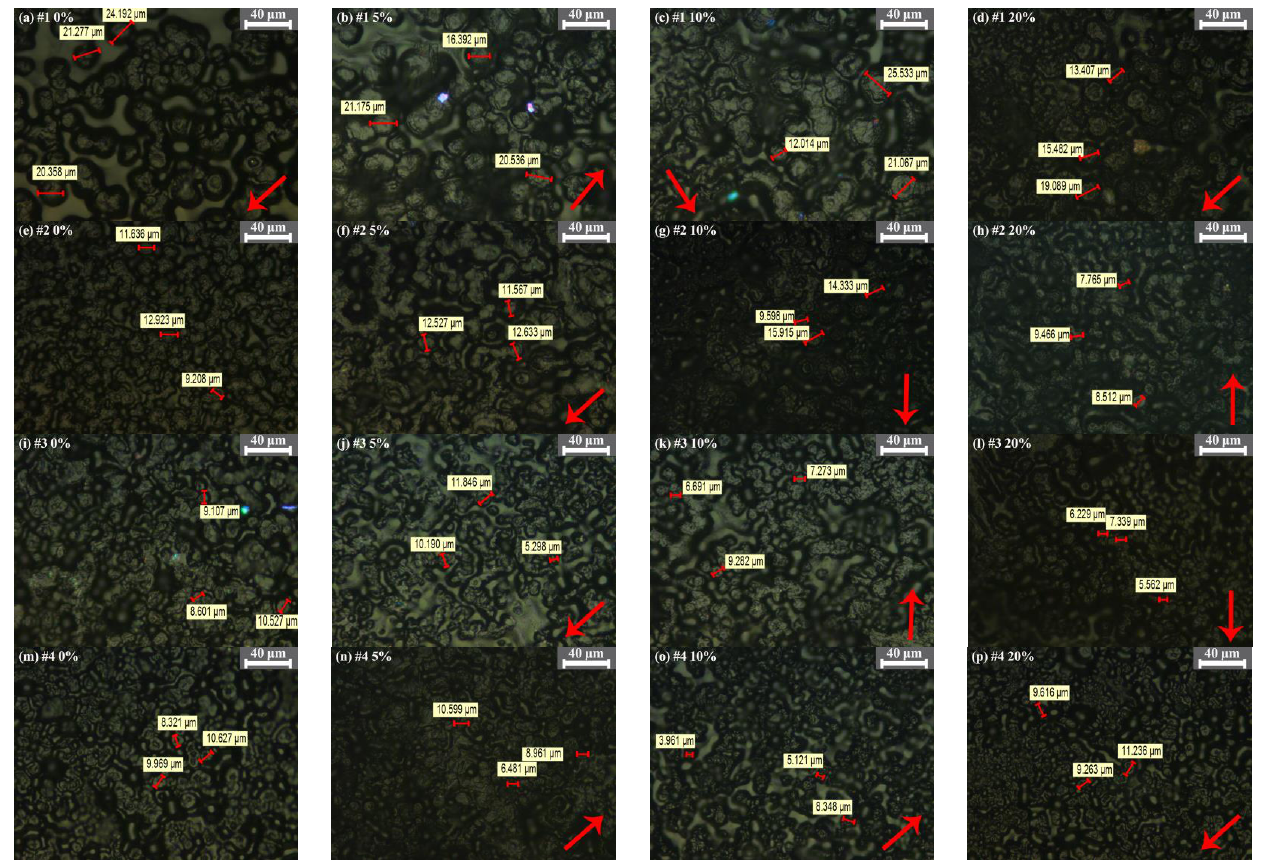
Figure 4. The crystalline morphology of all samples (the red arrow indicates the direction of tensile stress). (( a – d ) are the crystalline morphology of sample 1 at 0%, 5%, 10% and 20% tensile ratios respectively; ( e – h ) are the crystalline morphology of sample 2 at 0%, 5%, 10% and 20% tensile ratios respectively; ( i – l ) are the crystalline morphology of sample 3 at 0%, 5%, 10% and 20% tensile ratios respectively; ( m – p ) are the crystalline morphology of sample 4 at 0%, 5%, 10% and 20% tensile ratios